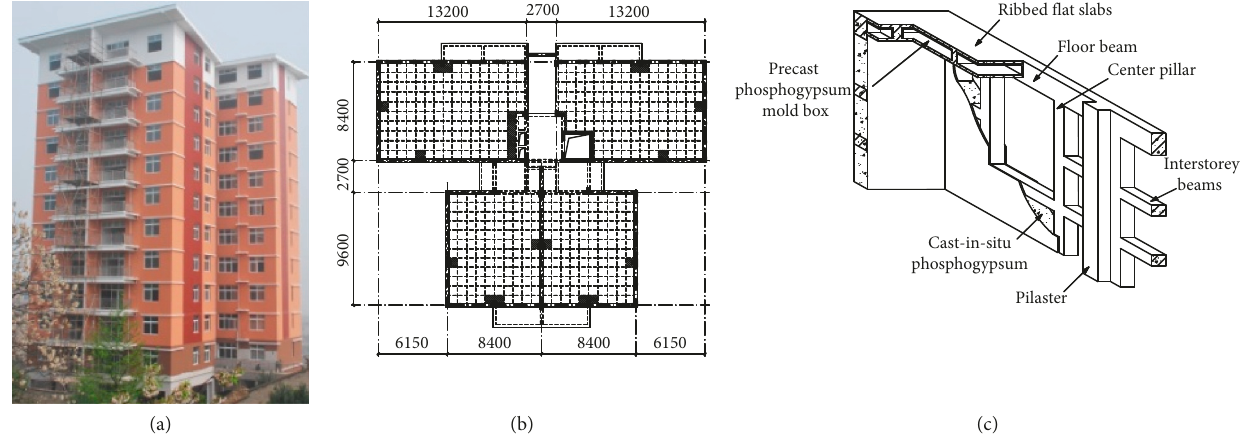
Figure 6: Guizhou Machangping high-rise housing. (a) Building elevation. (b) Structural plan. (c) Structural space diagram.